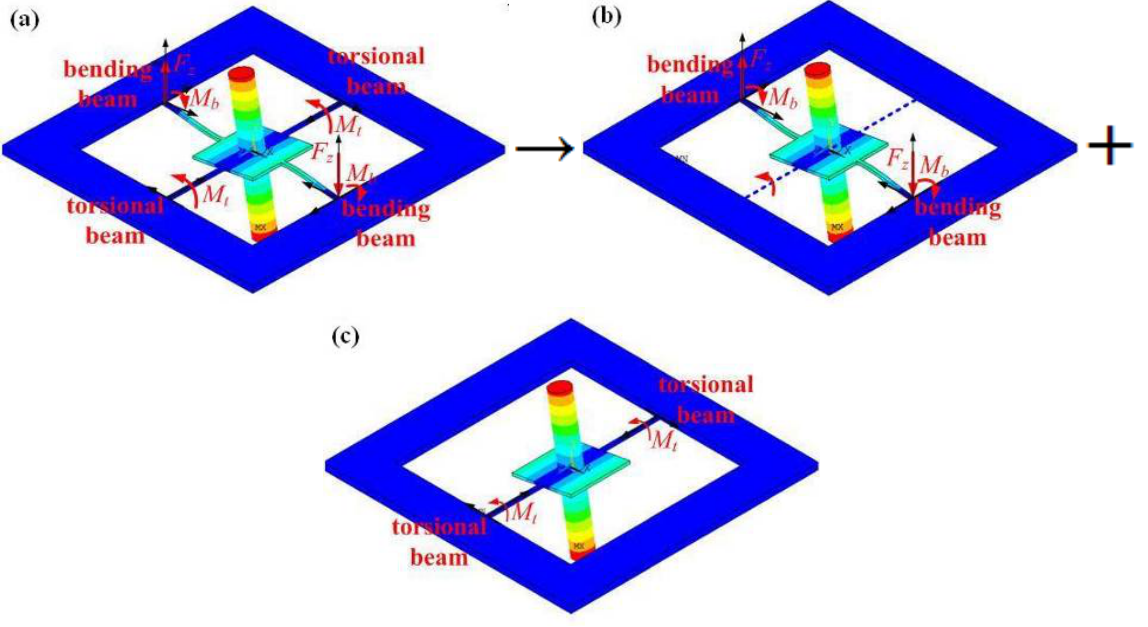
Figure 3. The support loads of RMG and the equivalent SDOF system. (a) Attached loads of RMG. (b) rocking mode of SDOF system. (c) torsional mode of SDOF